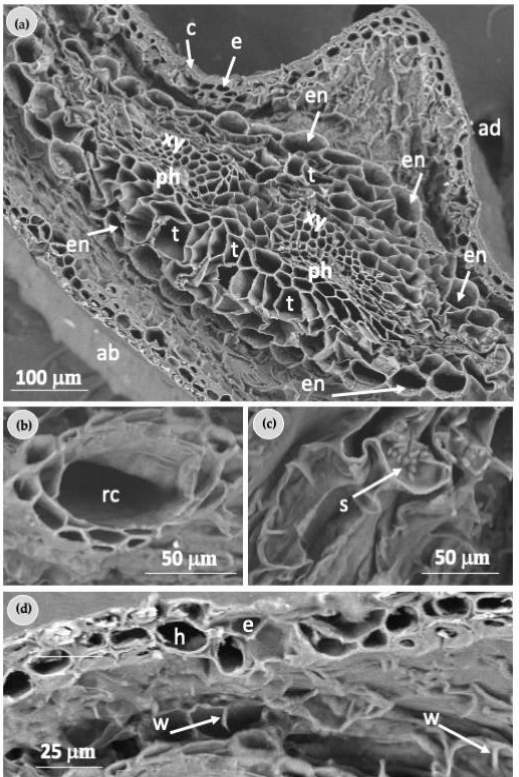
Figure 6. Scanning electron microscopy details of the organization of Pinus ponderosa needle from field-growing plants: ( a ) middle zone showing the organization of the vascular and surrounding tissues; ( b ) higher magnification of a resin duct (rc); ( c ) starch grains (s) in the parenchyma cells (transfusion tissue) surrounding the vascular bundles; ( d ) ridge-like invaginations (w) typical of the cell walls of the mesophyll parenchyma cells. ab—abaxial surface; ad—adaxial surface; c—cuticle; e—epidermis; en—endodermis; h—hypodermis; ph—phloem; rc—resin duct; t—transfusion